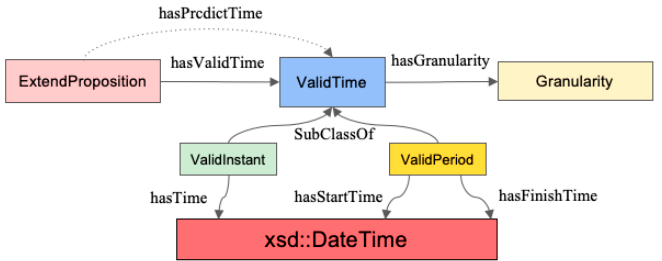
Figure 4. SWRL temporal ontology.